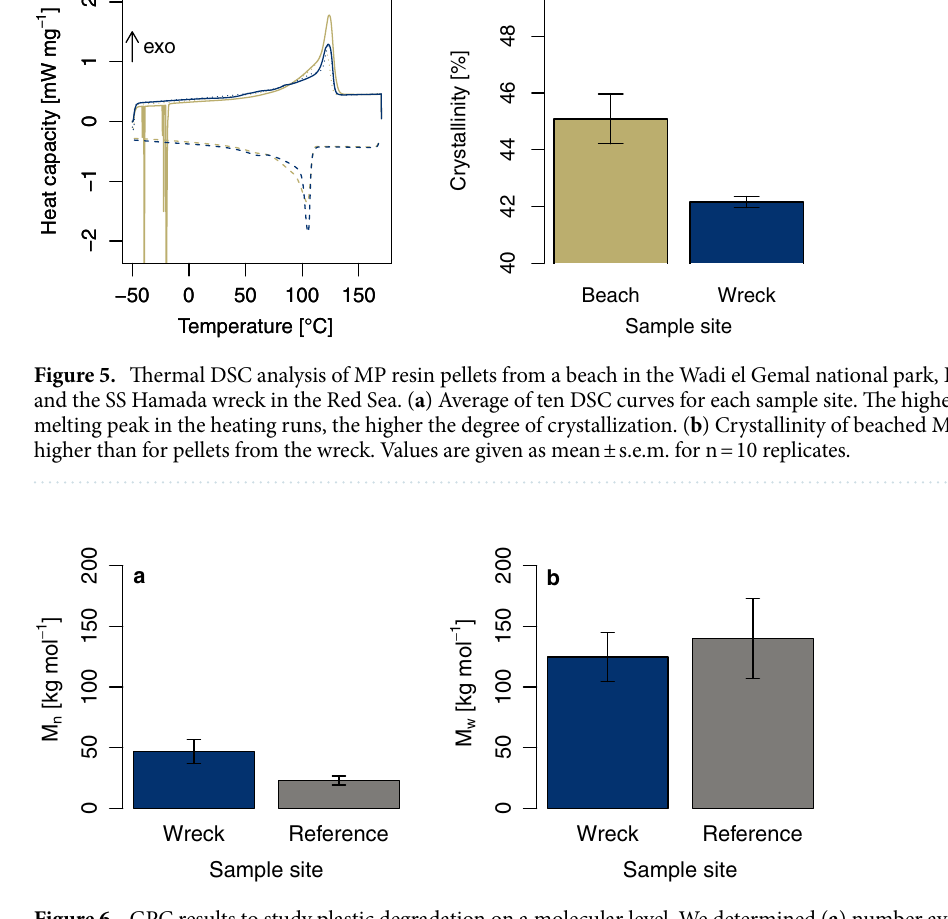
Figure 6. GPC results to study plastic degradation on a molecular level. We determined ( a ) number average molar mass (M n ) and ( b ) mass average molar mass (M w ) of MP resin pellets from the SS Hamada wreck in the Red Sea. No data for MP resin pellets from the beach is shown here as it was impossible to dissolve particles. Reference data for LDPE was obtained from the literature 44 . Values are given as mean ± s.e.m. for n = 5 replicates in case of MP from the SS Hamada wreck and n = 6 for reference